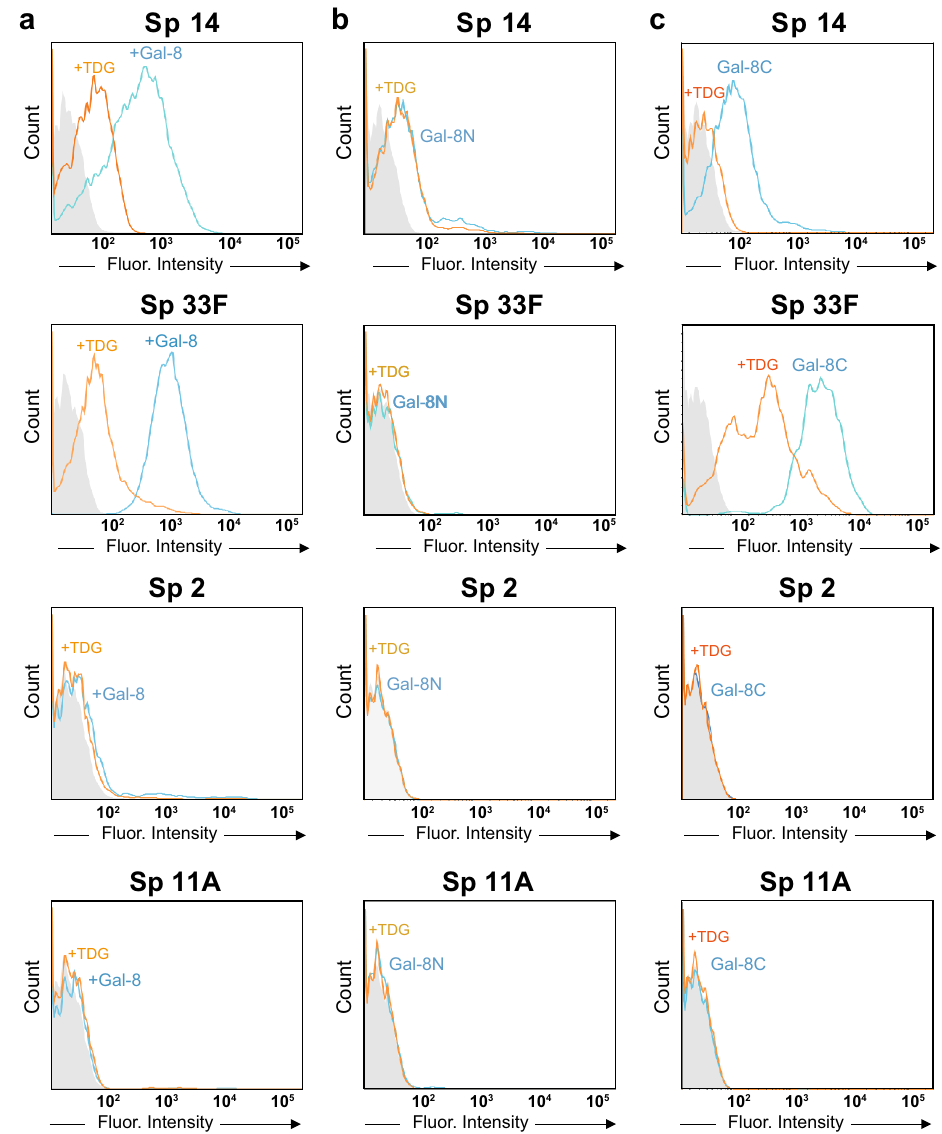
Figure 2. Gal-8 recognizes specific serotypes of S. pneumoniae on the flow cytometry analysis. ( a , b , and c ) Flow cytometric analysis of Gal-8 ( a ), Gal-8N ( b ), and Gal-8C ( c ) binding to Sp 14, 33F, 2 and 11A with or without inclusion of final concentration 50 mM TDG as indicated. TDG is labeled in orange. Unstained control is labeled in gray. Each respective galectin is labeled in